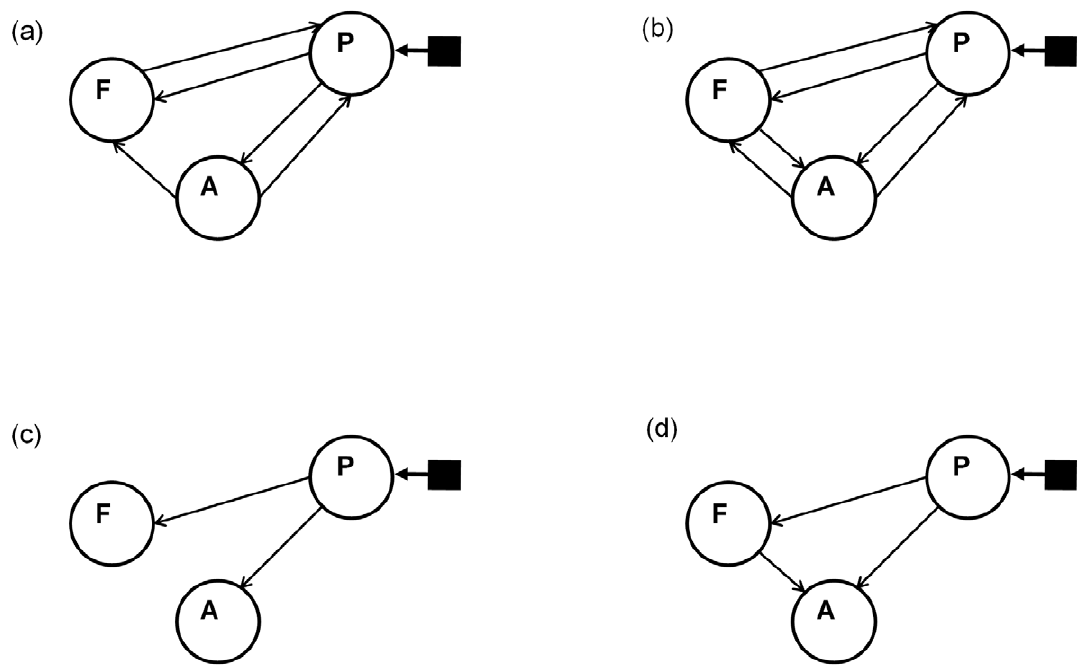
Figure 6. Likely models. The figure shows the input (filled square and solid arrow) and modulatory connectivity (solid arrows) stuctures for four models in Occam’s window (assessed using FFX). Note that all models also have full endogenous connectivity (not shown). These four models are (a) model m ~ 185 with p ( m D Y ) ~ 0 : 0761 , rank=1, (b) model m ~ 191 with p ( m D Y ) ~ 0 : 0759 , rank=2, (c) model m ~ 136 with p ( m D Y ) ~ 0 : 0507 , rank=15 and (d) model m ~ 163 with p ( m D Y ) ~ 0 : 0504 , rank=16. All models have auditory input entering region